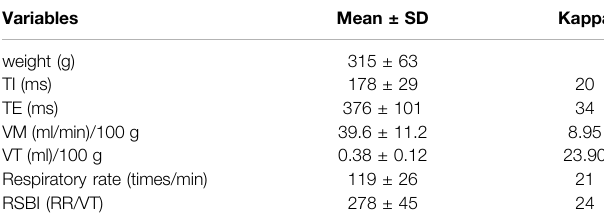
TABLE 1 | Whole body plethysmography in unanesthetized rats.